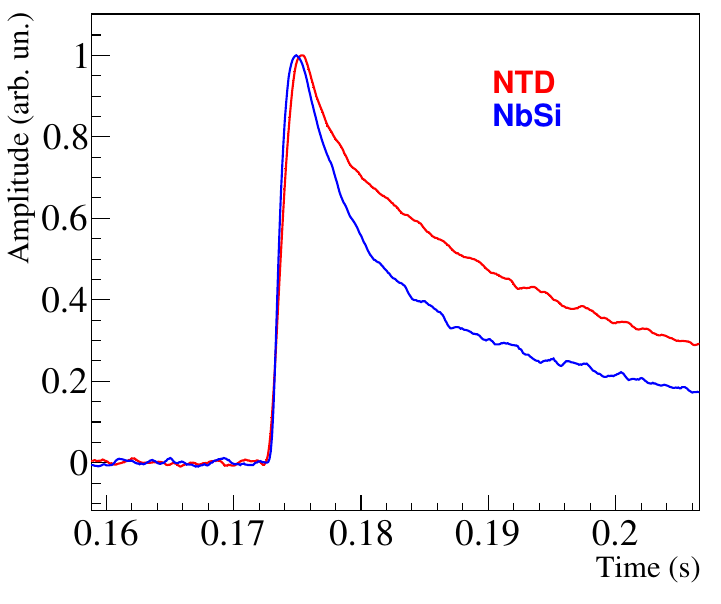
Figure 12 . Comparison between normalized pulses provided by the NbSi sensor and by the NTD Ge thermistor for the same bulk event, collected with Detector 4 of table